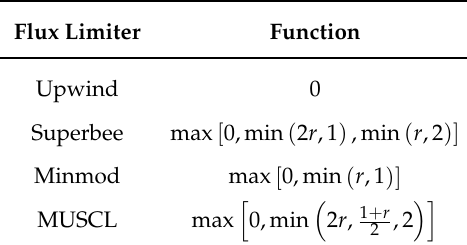
Table 1. Flux limiter functions used in the model